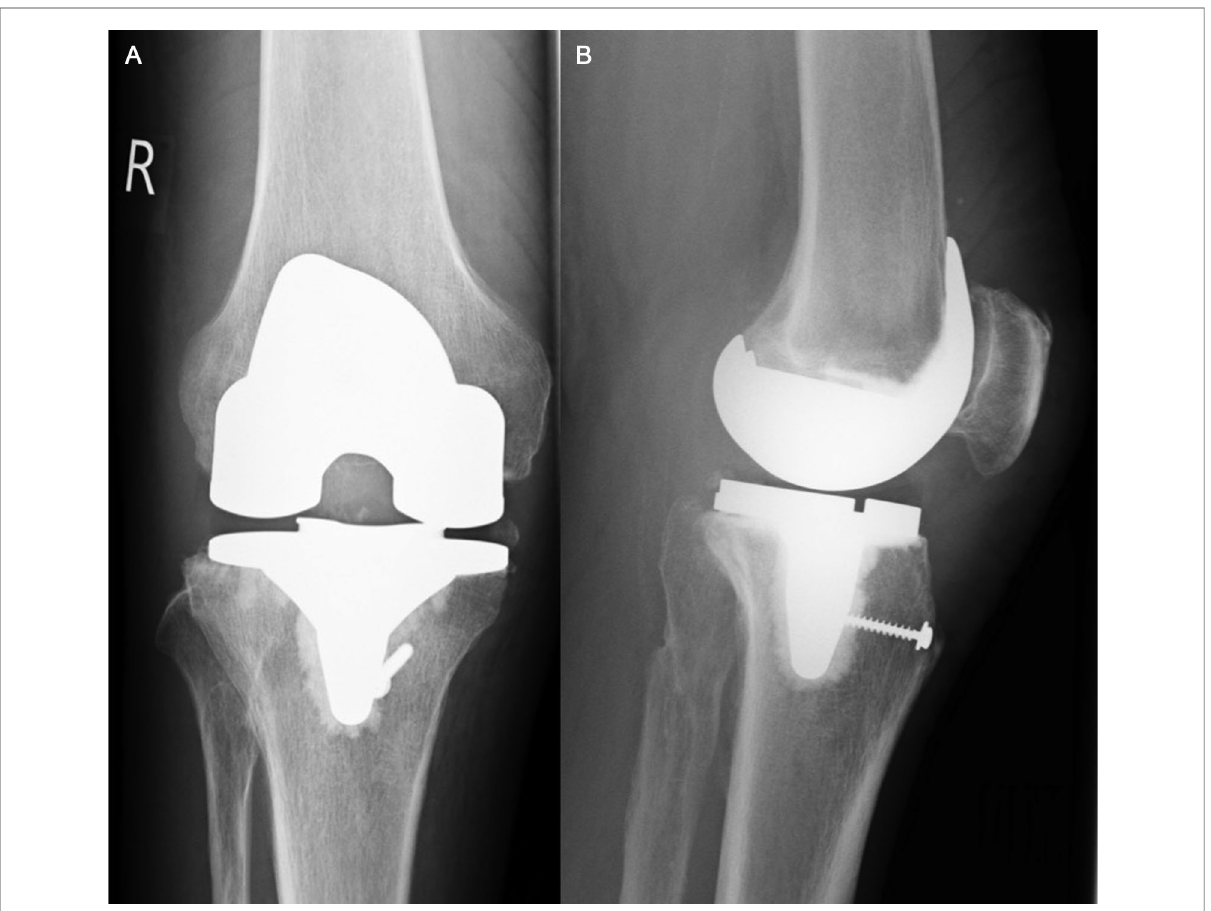
FIGURE 2 ( A,B ) Marlex Mesh fi xation. Postoperative antero-posterior ( A ) and lateral ( B ) x-ray views of the knee three months after Marlex Mesh reconstruction. Regarding its distal fi xation, a trough was created in the proximal-anterior aspect of the tibia. Additionally, a lag screw was placed across the mesh (as described under “ 2.2 Surgical Technique and Rehabilitation Protocol ”